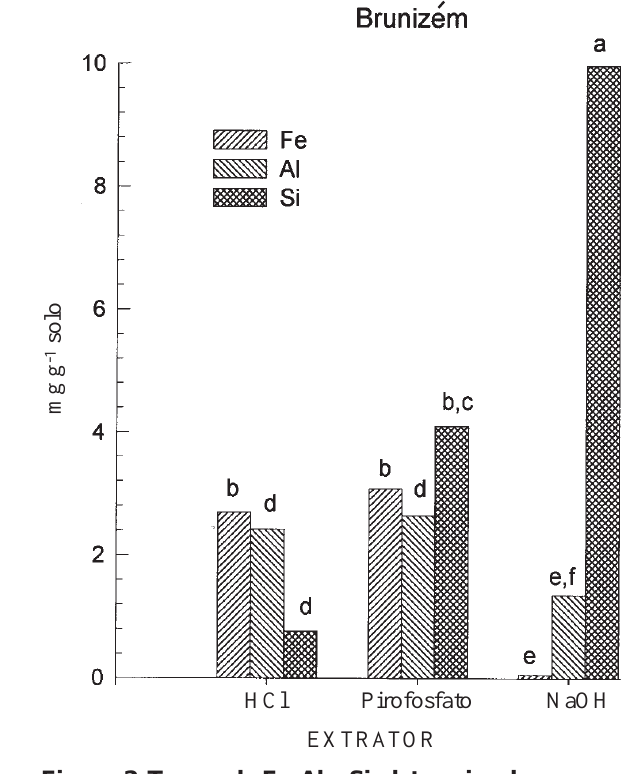
Figura 2. Teores de Fe, Al e Si, determinados nos ex- tratos de HCl 0,5 mol L -1 , pirofosfato 0,15 mol L -1 (pH 7) e NaOH 0,5 mol L -1 do método 2, no B. Letras minúsculas diferenciam médias, pelo teste de Duncan a 5%, para cada elemento em todas as três amostras das figuras 1, 2 e